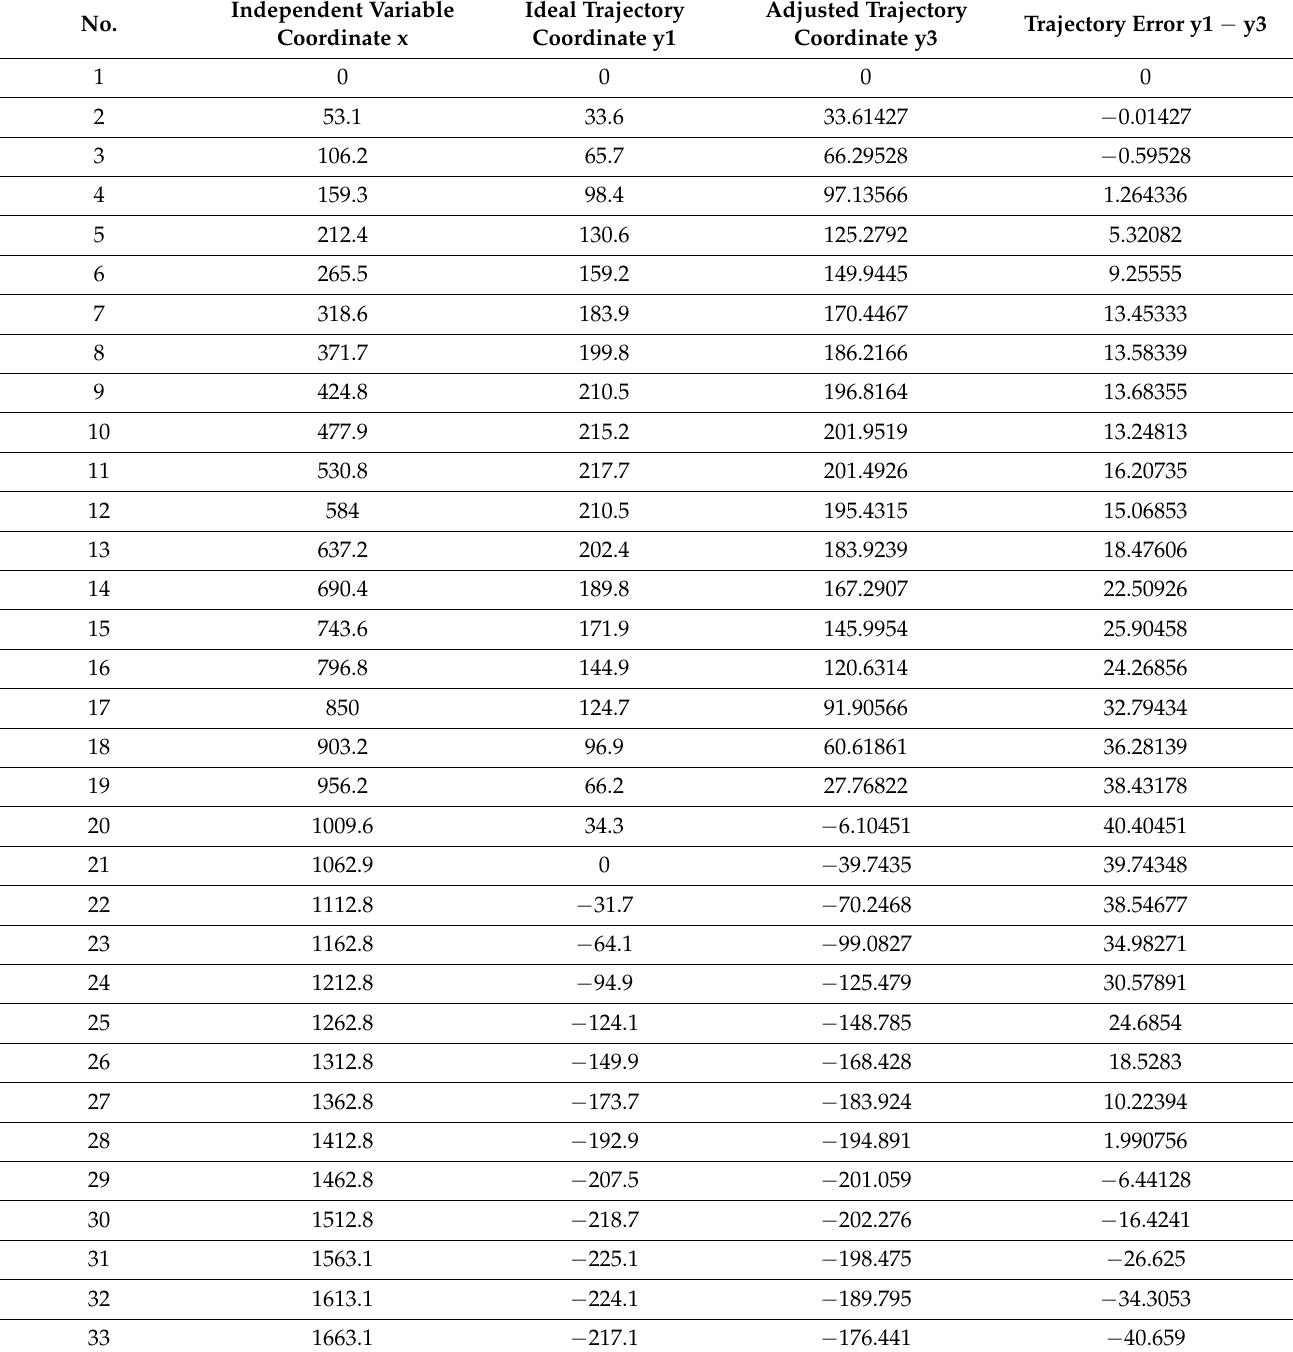
Table A2. Adjusted trajectory